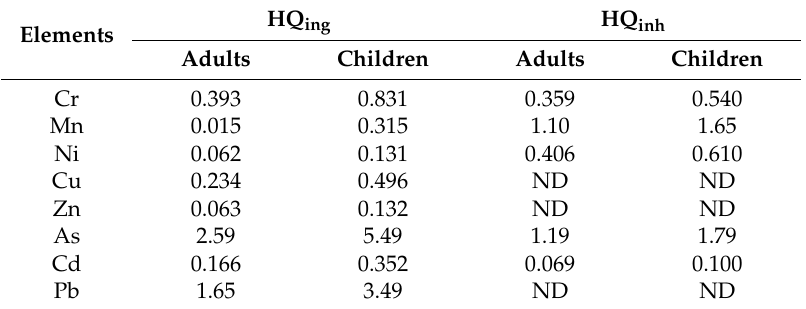
Table 1. The values of hazard quotient via ingestion (HQ ing ) and inhalation (HQ inh ). HQ > 1 suggests the probability of adverse health effects.